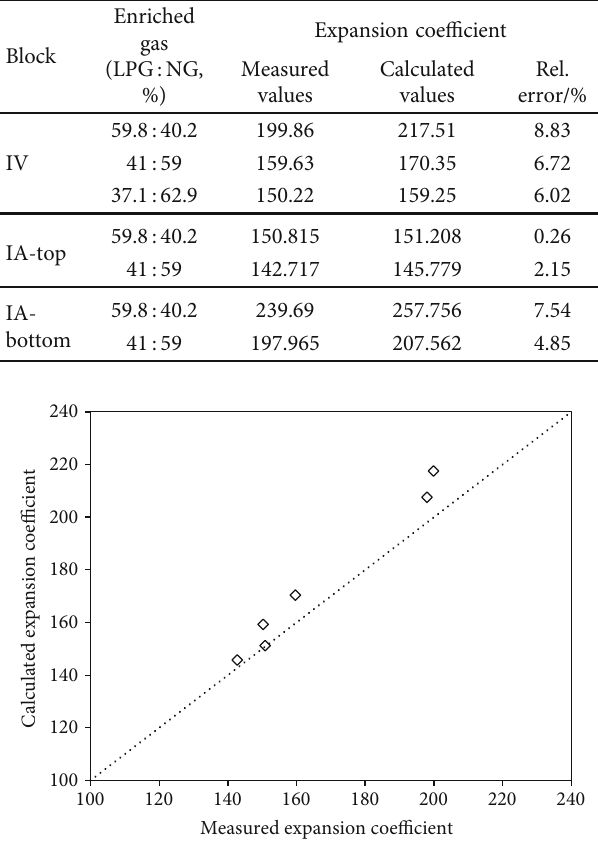
Figure 3: Comparison of calculated expansion coe ffi cient against the measured values. The dashed lines indicate relative errors equal to